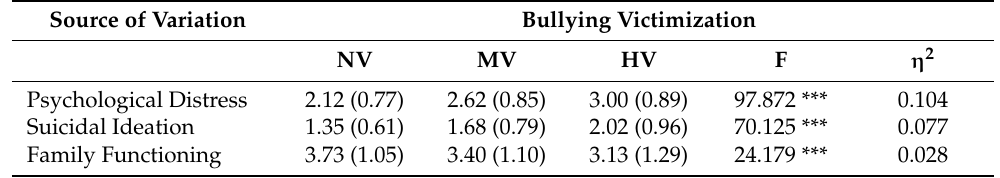
Table 4. ANOVAS in function of victimization.